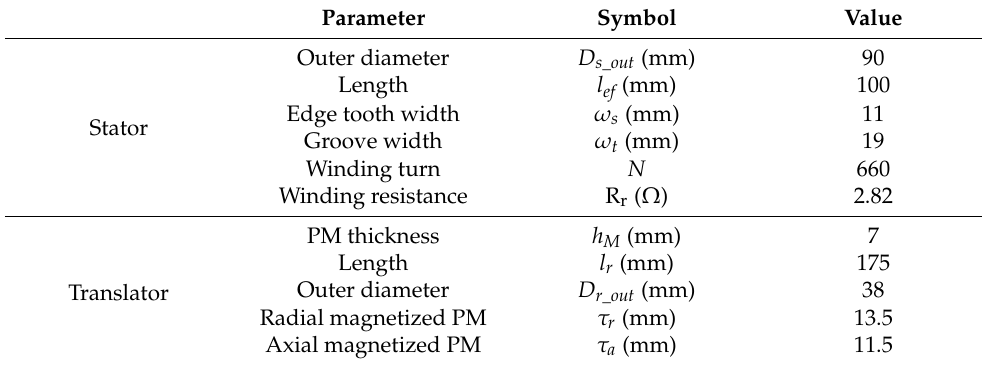
Figure 7. Effect curve of orthogonal design results. ( a ) Effect curve of EMF; ( b ) Effect curve of THD. Table 4. PMLG structure and dimension parameters.